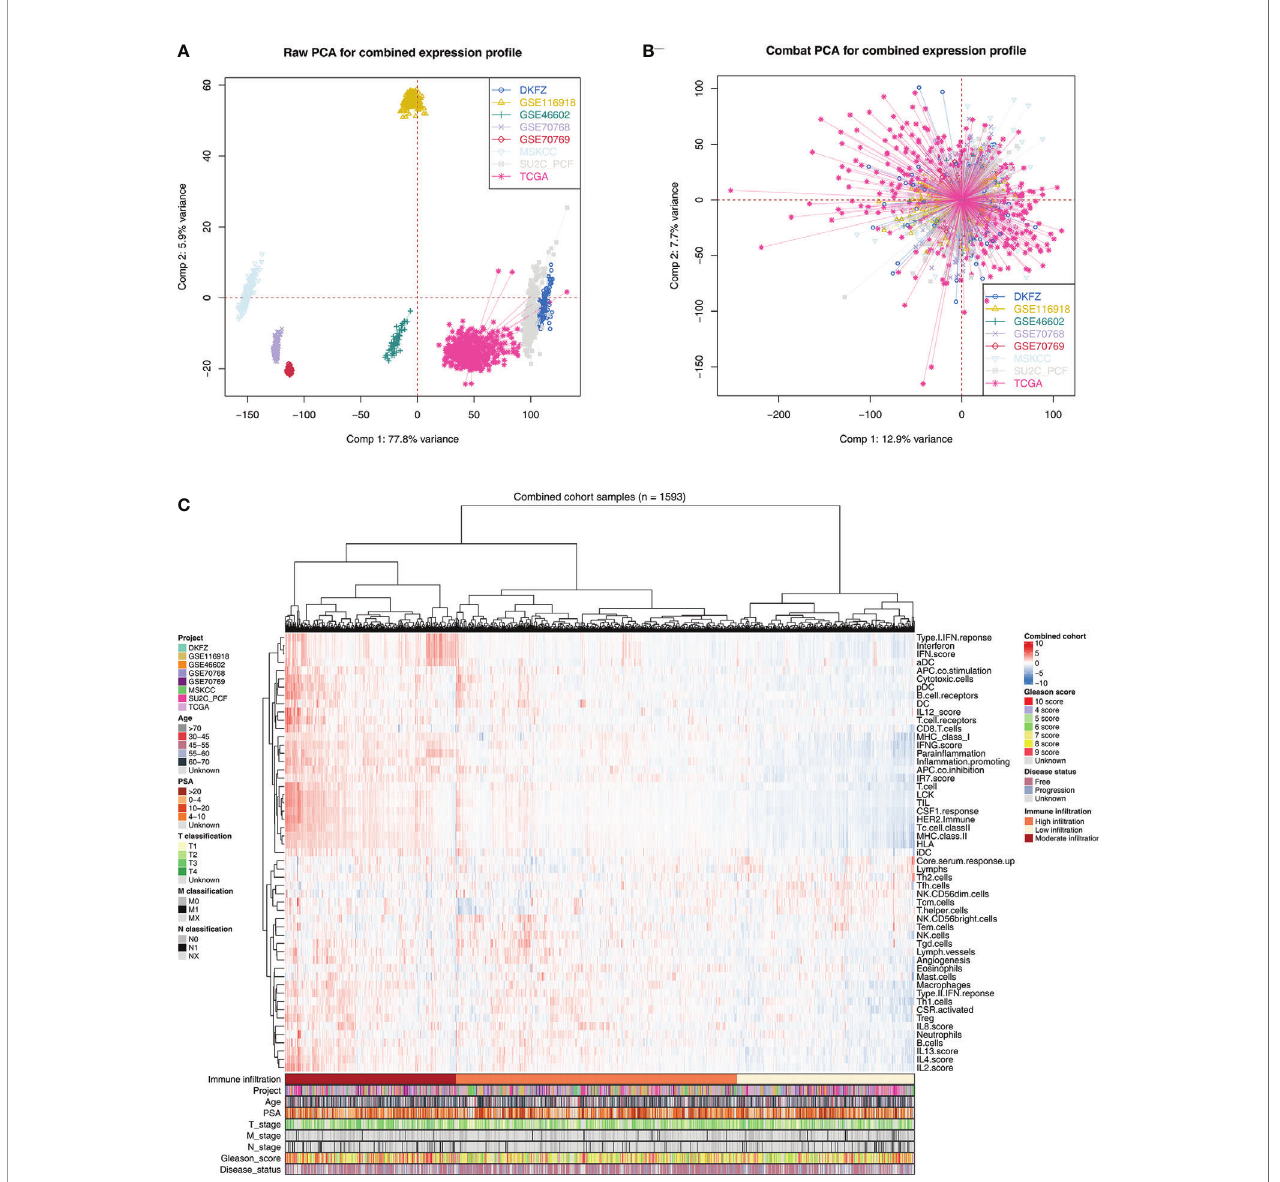
FIGURE 2 | Combination of PCa cohort and quanti fi cation of immune terms. (A) Eight PCa cohort selected for our analysis have obvious batch difference. (B) The sva package used for PCa cohort combination greatly reduces the batch difference. (C) Expression pro fi le of all patients was quanti fi ed as 53 immune terms using ssGSEA package. These immune terms were shown in the heatmap with their corresponding clinical